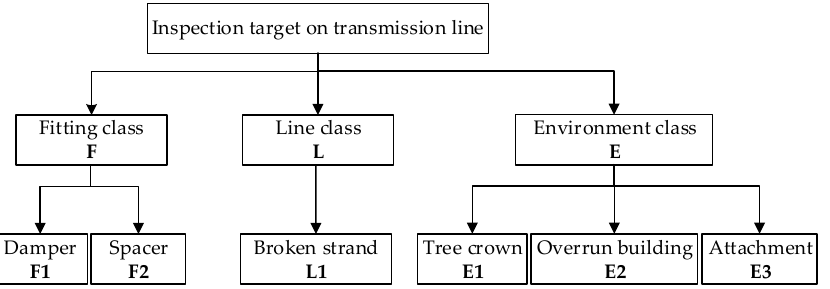
Figure 5. The classification of inspection targets on a transmission line.